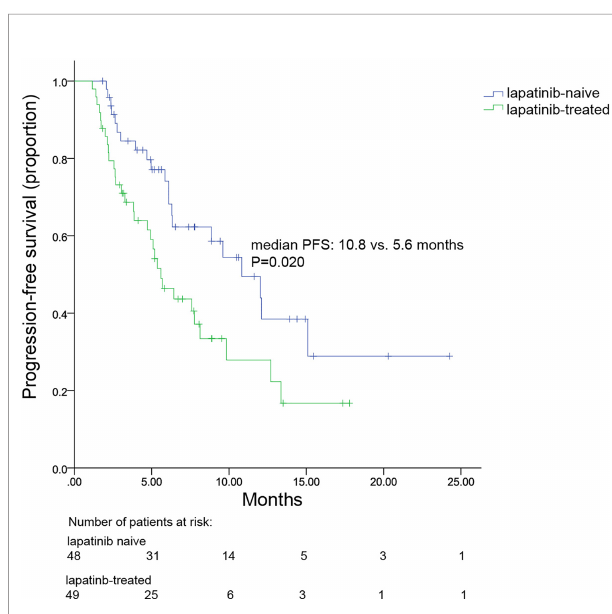
FIGURE 5 | Kaplan – Meier plot for progression-free survival of patients with or without prior lapatinib exposure.